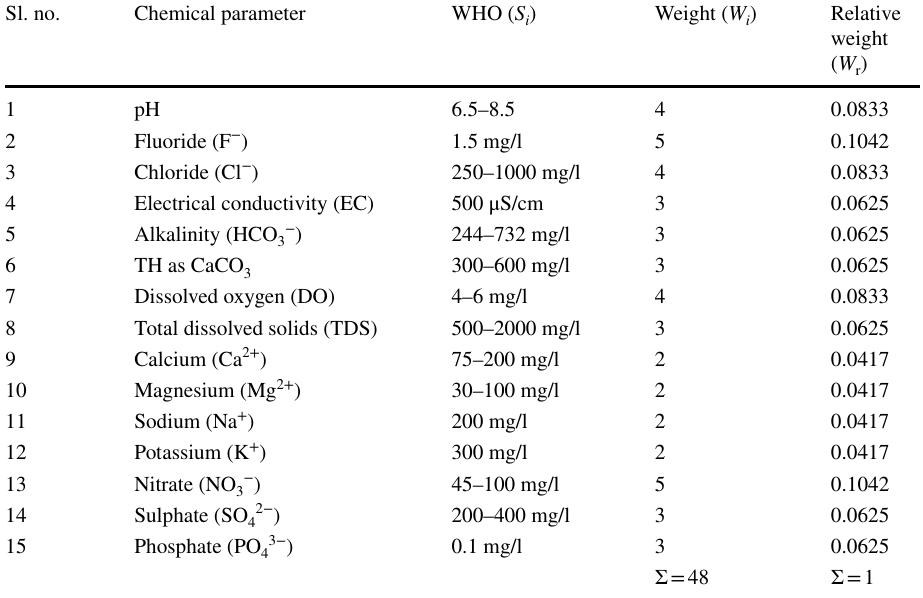
Table 3 Standards ( S i ), assigned weight ( W i ) and relative weight ( W r ) for evaluation of WQI